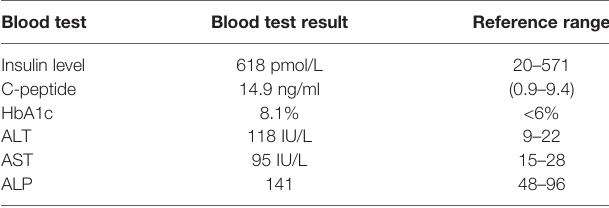
TABLE 1 | Results of laboratory tests done. Blood